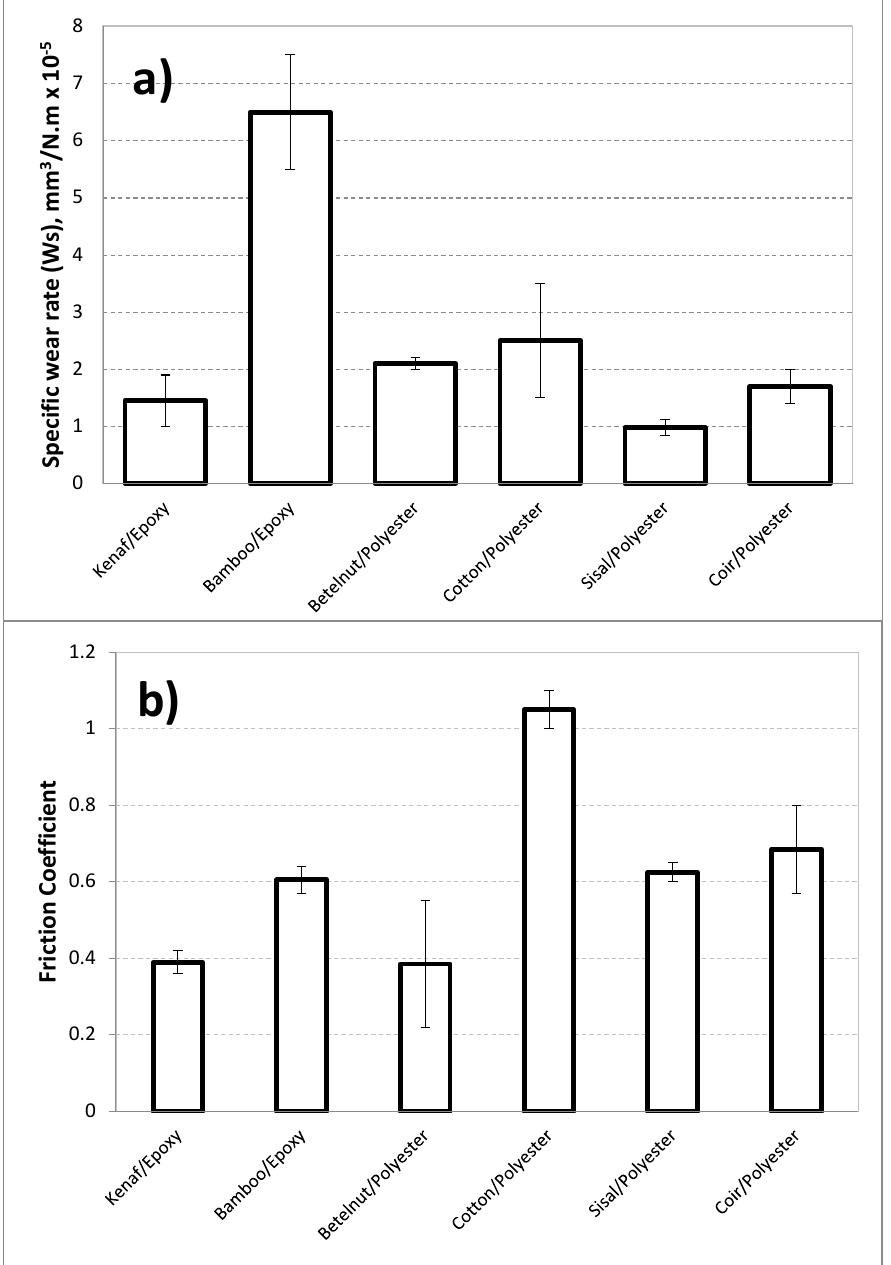
Figure 1. Specific wear rate ( a ) and friction coefficient ( b ) of some polymeric composites under dry contact conditions [16].